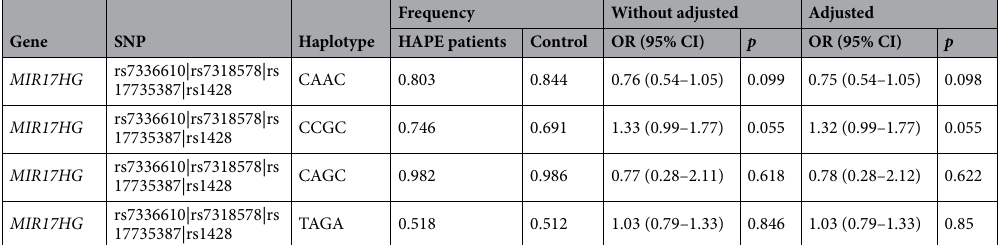
Gene SNP Haplotype